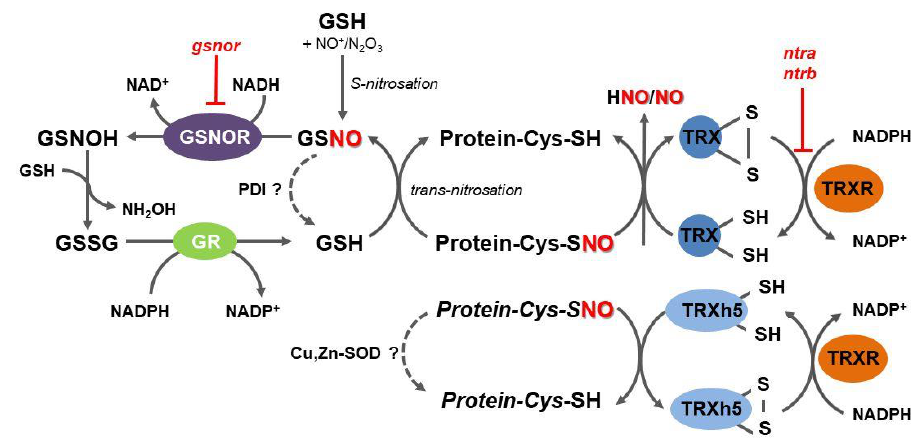
Figure 1. Overview of the mechanisms of protein denitrosation in plant cells. Within thioredoxin (TRX) structure, cysteine thiols present in a dithiol motif (CXXC) remove the nitroso group from S-nitrosated protein substrates, resulting in a disulfide bond formation in cytosolic TRX and free NO and related reactive nitrogen species (RNS). Reduced TRX is regenerated by NADPH-dependent thioredoxin reductase (TRXR). A specific subset of S-nitrosated proteins is denitrosated by TRXh5 in regulatory pathways of the plant immunity. A trans-nitrosation equilibrium between reduced and S-nitrosated proteins and glutathione (GSH), respectively, can be shifted by S-nitrosoglutathione reductase (GSNOR), catalyzing an irreversible NADH-dependent reduction of S-nitrosoglutathione, leading to unstable N-hydroxysulfinamide intermediate (GSNOH), which can further react with GSH to oxidized glutathione (GSSG) and hydroxylamine. GSH can be eventually regenerated by an NADPH-dependent reduction of GSSG catalyzed by glutathione reductase (GR). GSNO might be directly decomposed by protein disulfide isomerase (PDI), whereas S-nitrosoproteins might be potentially denitrosated by Cu,Zn-superoxide dismutases (Cu,Zn-SOD); ntra ntrb , Arabidopsis double mutant in NTRA and NTRB.